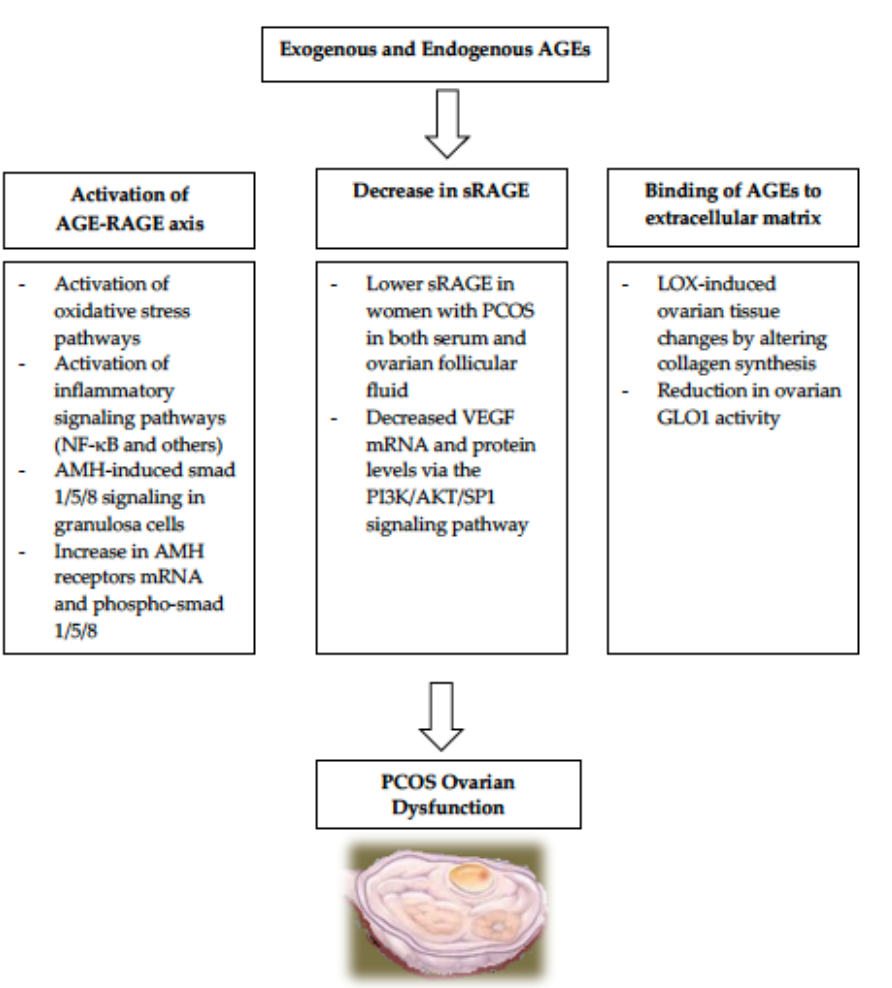
Figure 1. Systemic AGEs can be formed either endogenously or exogenously in women with PCOS. They contribute to the development of several key elements in PCOS via multiple pathways. NF-KB, nuclear factor kappa B; AMH, anti-mullerian hormone; mRNA, messenger RNA; PCOS, polycystic ovarian syndrome; LOX, lysyl oxidase; GLOX-1, glyoxalase 1.